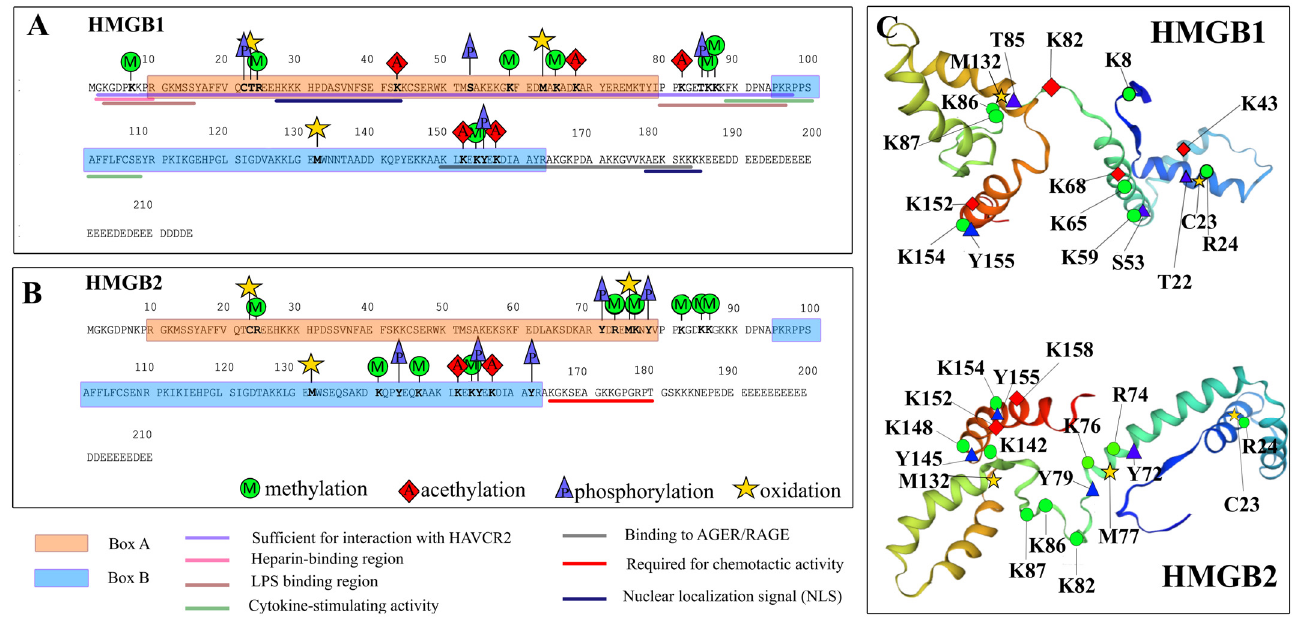
Figure 3. Post-translational modifications of calf thymus HMGB1 ( panel A ) and HMGB2 ( panel B ) non-histone proteins. The schematic representation of potential PTM site location ( panel C ) (the PTMs are also listed in the Table). Potential HMGB1 PTM sites that we have identified for the first time are located mainly in its DNA-binding A-domain and linker region connecting the A and B domains. On the contrary, HMGB2 PTMs are concentrated in the B domain and also within the linker region. However, the nature of the modifications within this region is different for HMGB1 and HMGB2, which might affect the functioning of these proteins. Table 2. The results of MALDI mass spectrometry analysis of HMGB1 and HMGB2 from calf thymus.